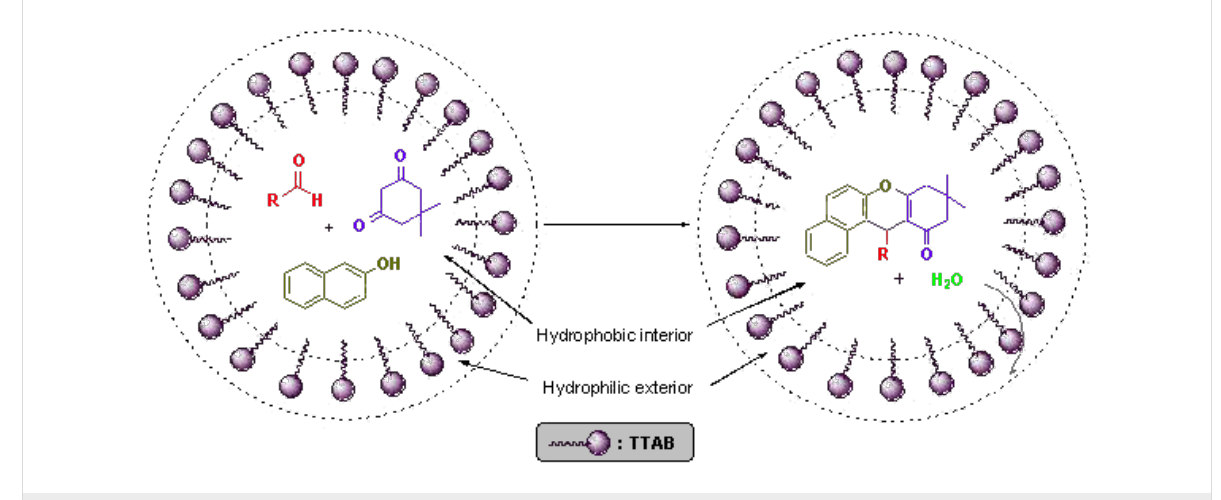
Figure 2: Schematic diagram representing the role of TTAB.